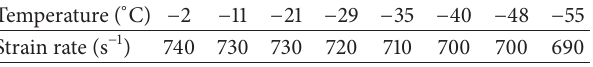
Table 1: The loading strain rates at different temperatures.